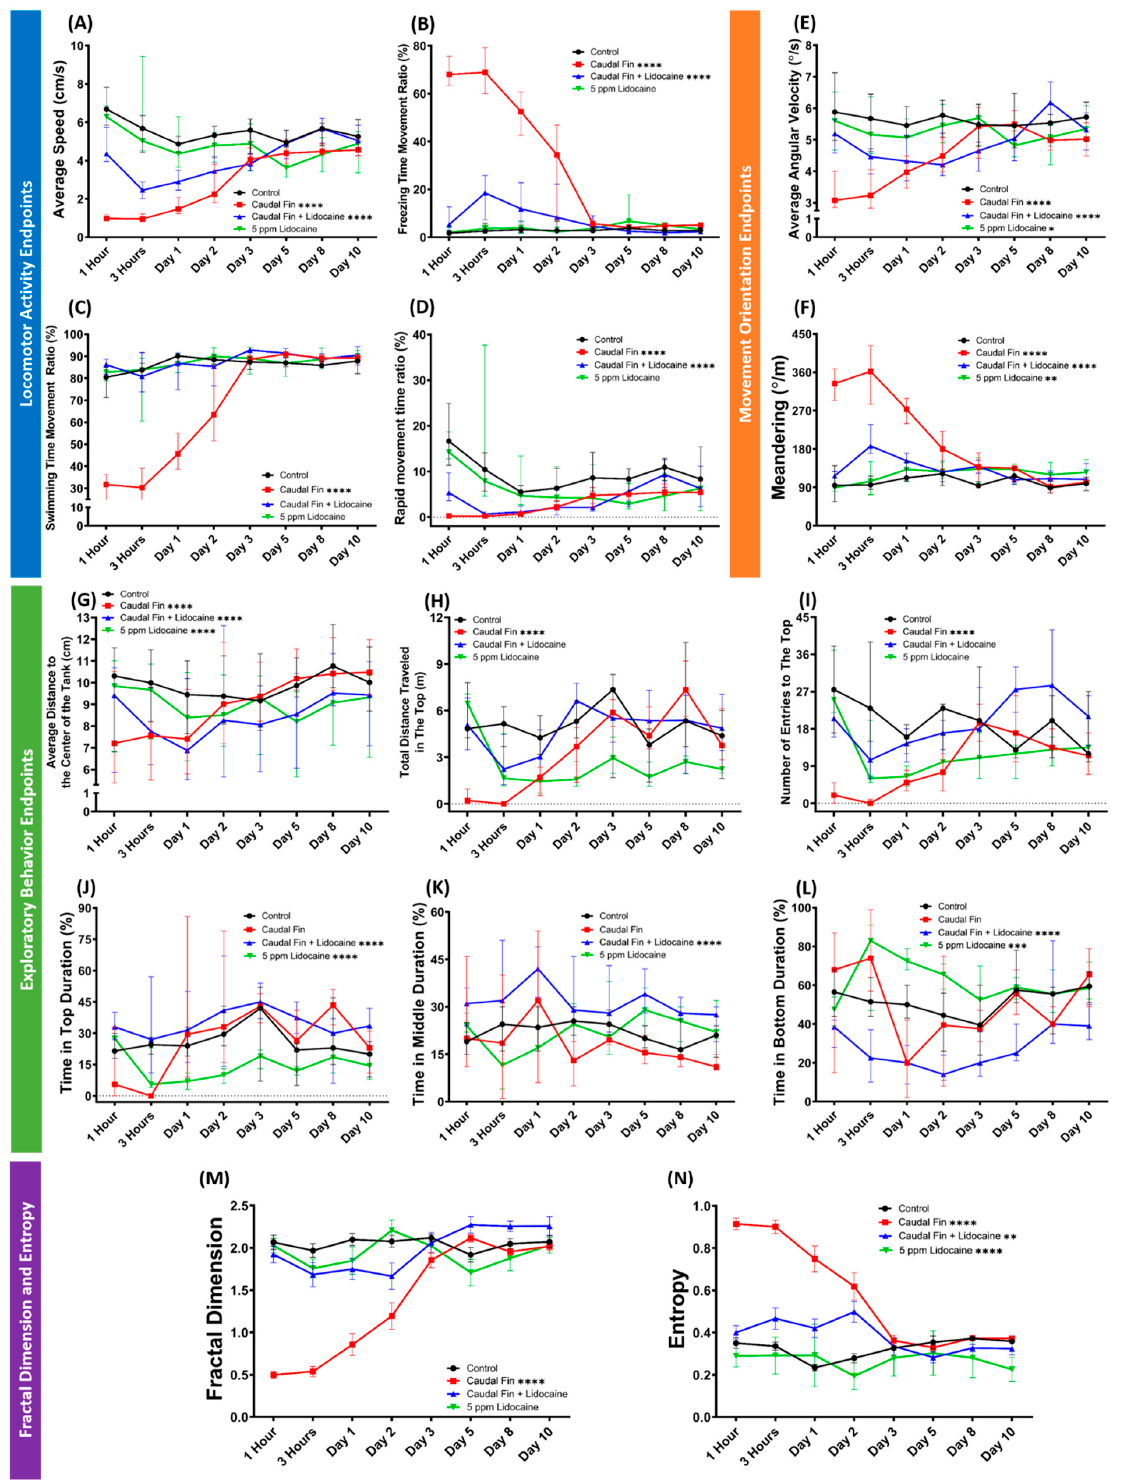
Figure 6. Comparison of grouped zebrafish behaviors in 3D locomotion test between caudal-fin- amputated group (red), caudal-fin-amputated + 5 ppm lidocaine group (blue), 5 ppm lidocaine-treated group (green), and untreated (black) group (shoal size = six fishes) over 10 days observation. Twelve endpoints were measured and categorized into three groups. ( A ) Average speed, ( B ) freezing time movement ratio, ( C ) swimming time movement ratio, and ( D ) rapid movement time ratio belong to the locomotor activity endpoints group, while the movement orientation endpoints group consists